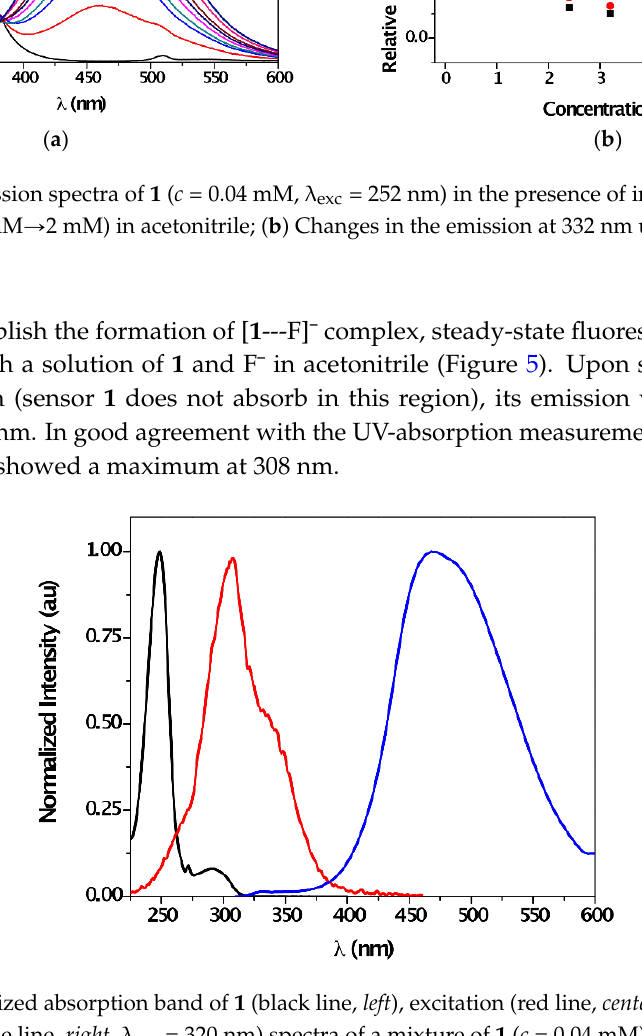
Figure 3. Benesi-Hildebrand plot used to determine the association constant of the CT complex formed by sensor 1 and F¯ (λ max = 300 nm) at different fluoride concentrations ([ 1 ] = 0.02 mM). In order to observe changes in the excited state, the fluorescence of 1 in the presence of increasing amounts of anions was investigated. In agreement with the marked variations detected in the ground state, emission of 1 was fully quenched by the presence of F¯ (Figure 4a), whereas a new comprehensive band with a maximum at ca. 460 nm appeared with the formation of an isoemissive point at 383 nm. On the other hand, the maximum emission intensity of 1 showed no changes in the presence of Cl¯, Br¯ and I¯ (Figure 4b, Figure S11 and Figure S12), which demonstrated the preference of sensor 1 for F¯. Furthermore, the detection limit of fluoride anion was established at around 0.003 mg·L −1 (see ESI, Figure S13); this fluoride concentration is categorized as low-fluoride water (up to 0.5 mg·L −1 ) [63]. Other related ureas, albeit lacking gelation ability, were found to be also suitable for sensing selectively fluoride anion among other halides (Figure S14). These results suggest that, at least in this case, the self-assembly tendency of the sensor does neither hinder nor favor its anion sensing properties. In addition, sensor 1 showed high affinity for other anions such acetate and phosphate, while the reverse was true for hydrosulfate (Figure S15). A static fluorescence quenching of sensor 1 seemed to occur since the Stern–Volmer plot presented a non-linear behavior at high amounts of fluoride (Figure S16). For comparison, a strong non-nucleophilic base such as 1,8-diazabicyclo[5.4.0]undec-7-ene (DBU) was also used. In this case,